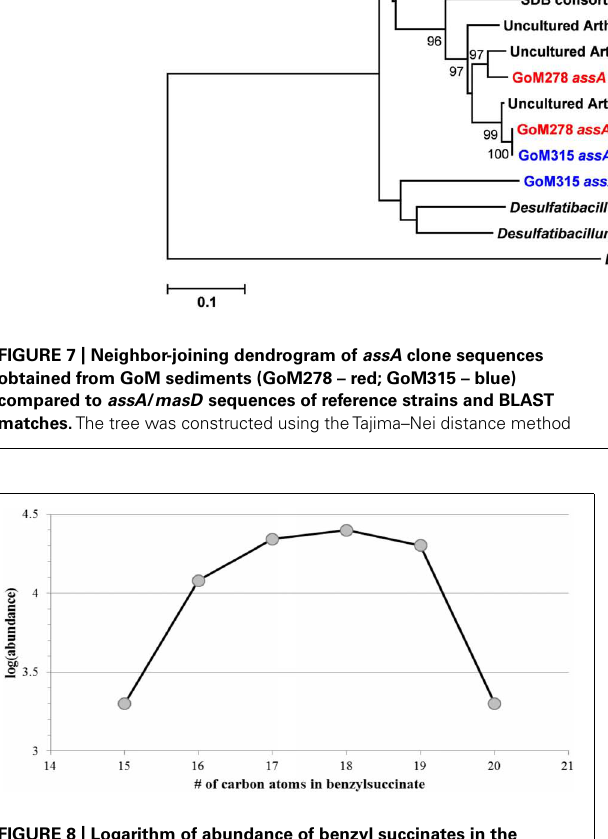
FIGURE 8 | Logarithm of abundance of benzyl succinates in the sample